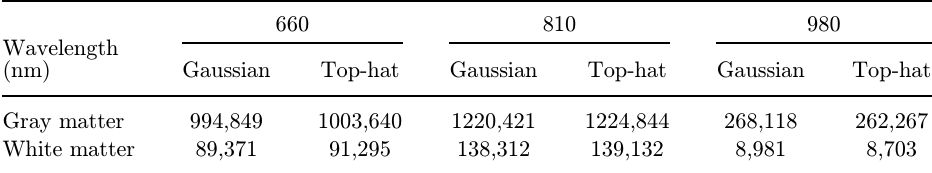
Table 2. Mean numbers of light penetrated voxels within brain tissue. Std < 0 : 01 %Mean .